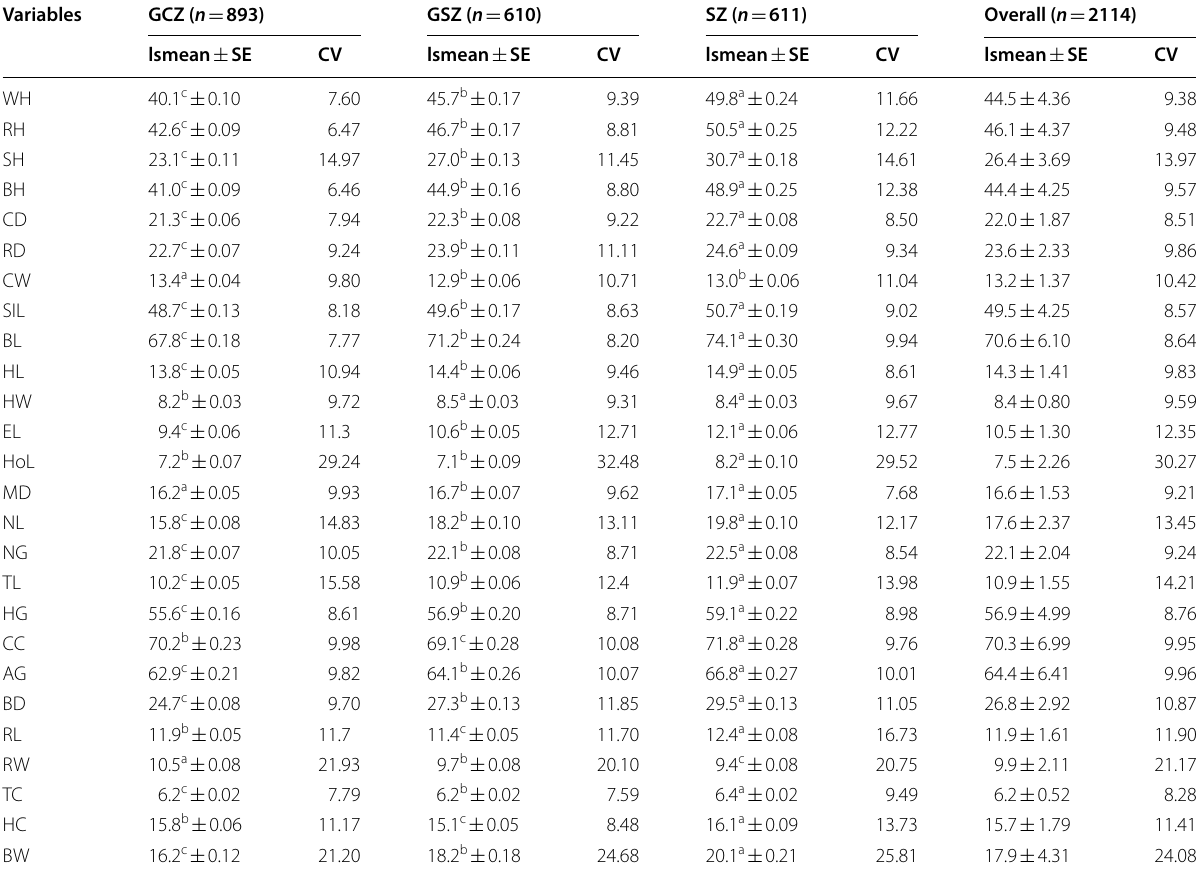
Table 1 Least squares means (lsmeans) and standard errors (SE) and coefficients of variation (CV) of morphological measurements